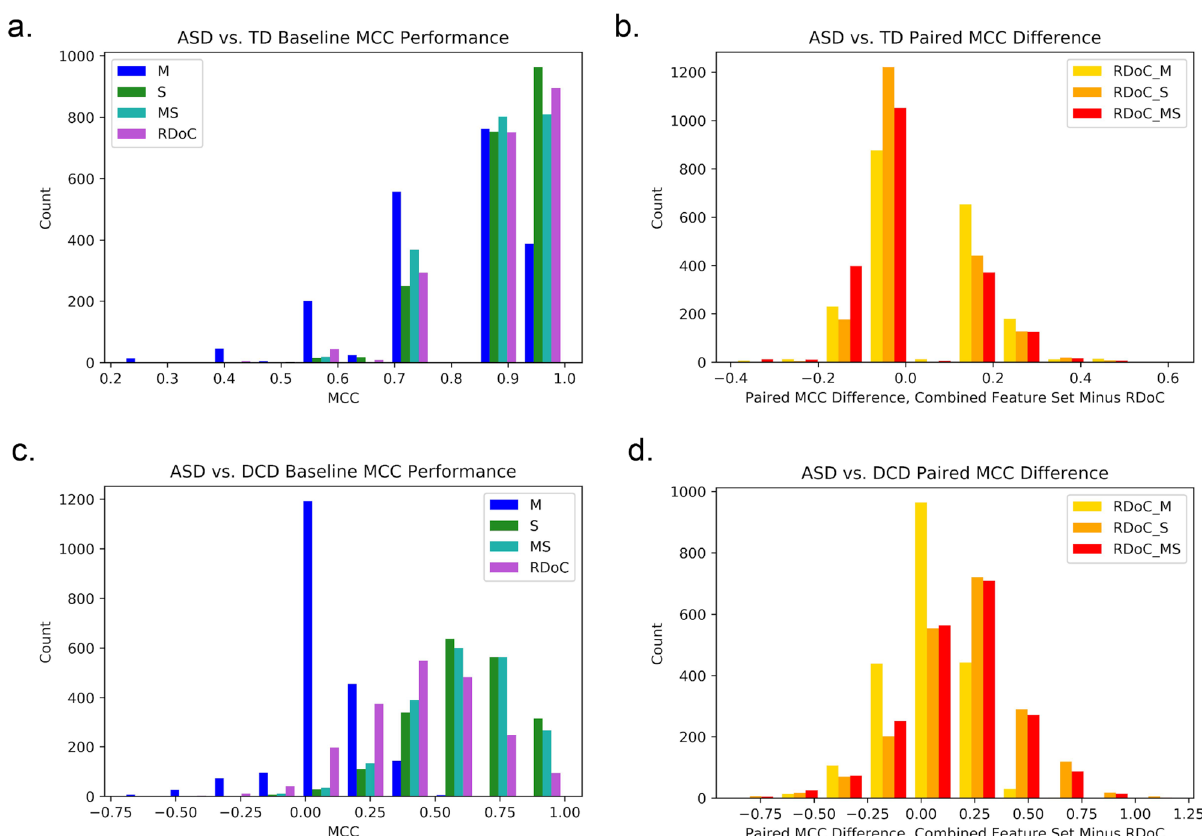
Figure 1. MCC decoding performance of optimized feature sets. Histogram of baseline MCC performance of separate feature sets in decoding ( a ) ASD from TD and ( c ) ASD from DCD across all 2000 CV folds in cool colors. Histogram of paired difference between combined feature sets and RDoC alone between ( b ) ASD and TD and ( d ) ASD and DCD in hot colors. M motor, S sensory, MS motor and sensory, RDoC_M RDoC and motor, RDoC_S RDoC and sensory, RDoC_MS RDoC, motor and